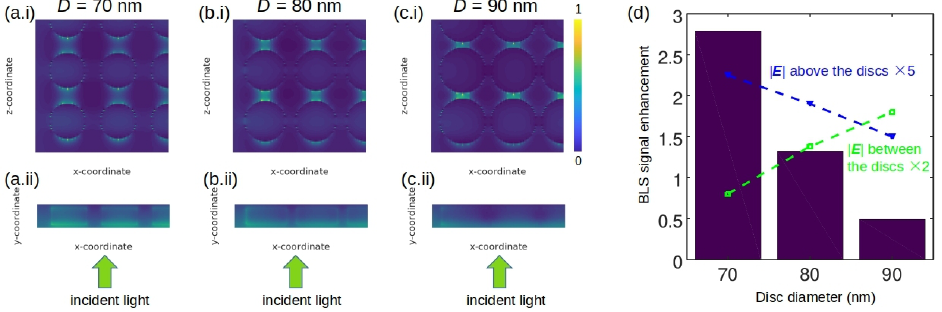
Figure 10. ( a–c ) Top and side views of the simulated optical electric field amplitude | E | of the plasmonic modes in the nanodisc array with different disc radii D . The direction of propagation of the 532nm-wavelength incident light is indicated. ( d ) Simulated BLS enhancement as a function of the disc diameter D . The triangles and squares and the straight lines (guides to the eye) corresponding to them show the dependence of the field enhancement above and between the discs,